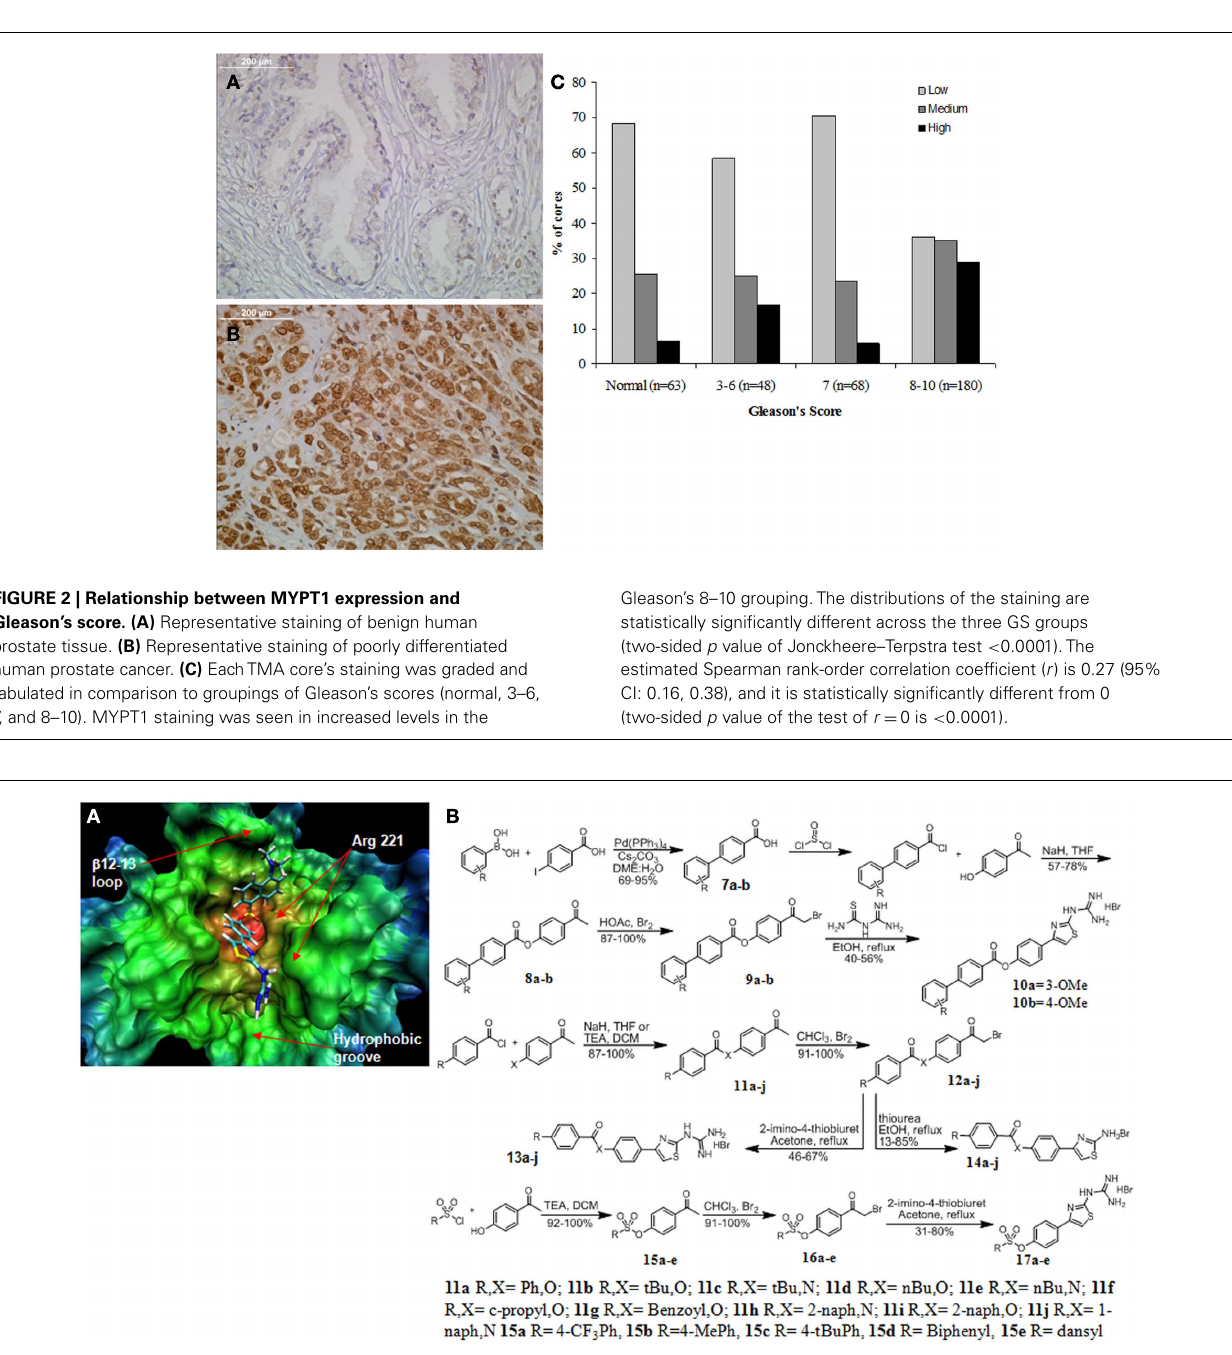
interacting with the hydrophobic groove and the dansyl portion of the molecule interacting with the β 12–13 loop. (B) Synthesis of MLCP